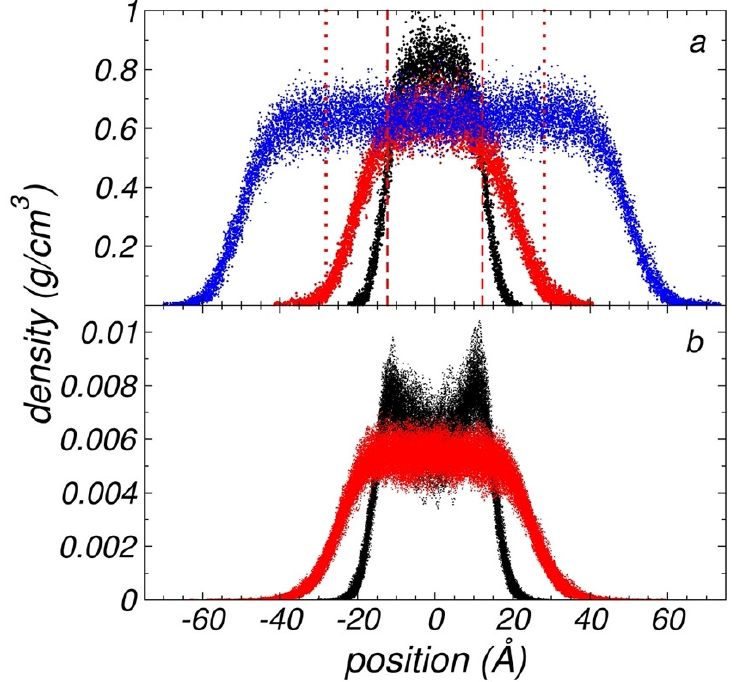
Figure 3. ( a ) Density profiles for the whole system and ( b ) density profiles for only the end CH 3 groups as a function of the inhomogeneous position within the simulation cell at their corresponding t c , for systems of polyethylene chains (C 200 ) at T = 373.15 K (black) and T = 673.15 K (red). Each point represents the average density over 1 ps of simulation. Blue points correspond to a thin layer at 673.15 K with a larger number of chains than the layer at its t c . Vertical dashed and dotted red lines represent z 90% and z 10% , respectively, for the layer at 673.15 K and at its t c .